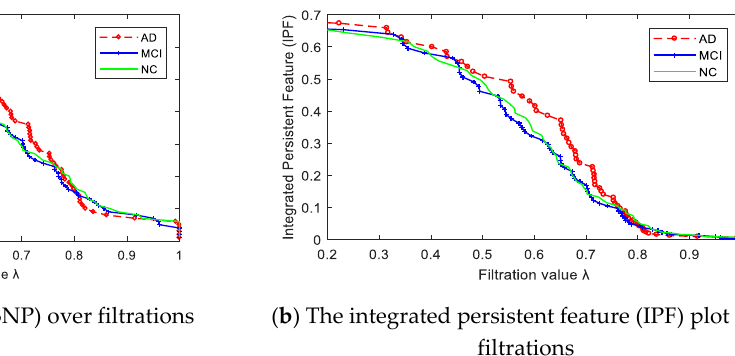
Figure 3. The persistent features plots of Betti number β 0 ( a ) and IPF ( b ) for three groups of mean networks.